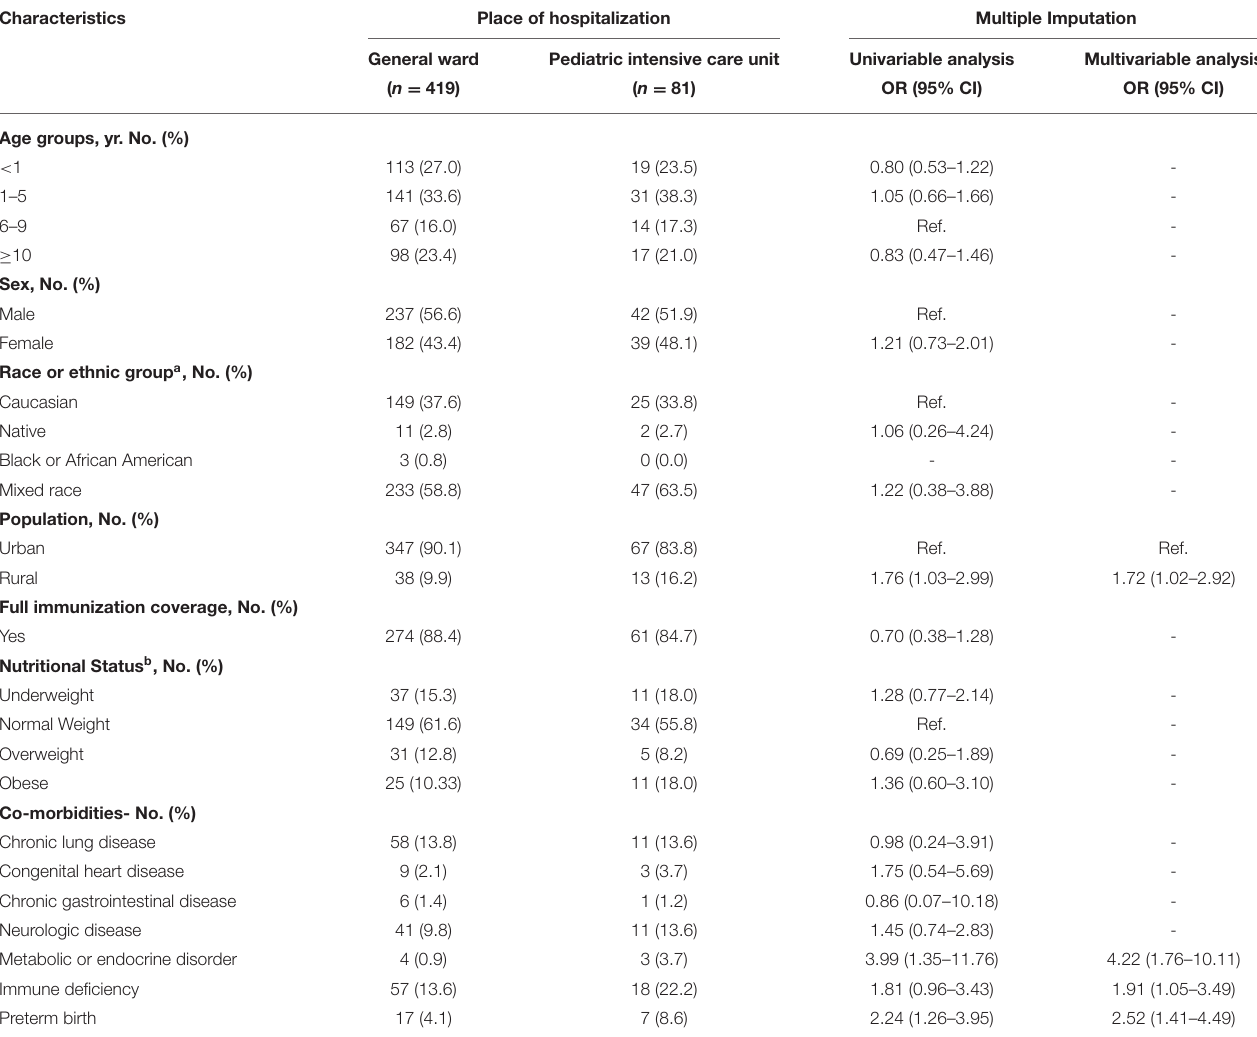
TABLE 4 | Demographic and underlying medical conditions associated with intensive care, among pediatric patients hospitalized due to COVID-19 using multiple imputation chained equations for missing data.